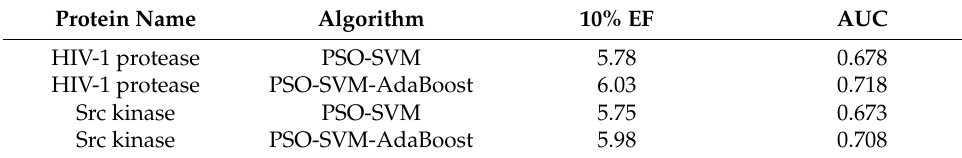
Table 1. Index comparison of two classification methods.